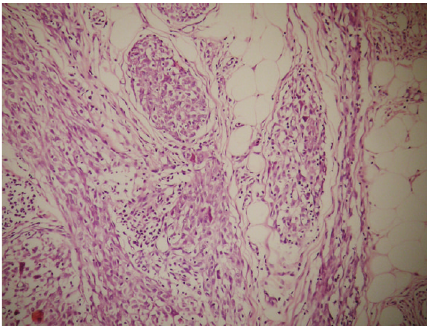
Figure 3: Two mitoses on HPF in some areas (hematoxylin-eosin, ×100 ).